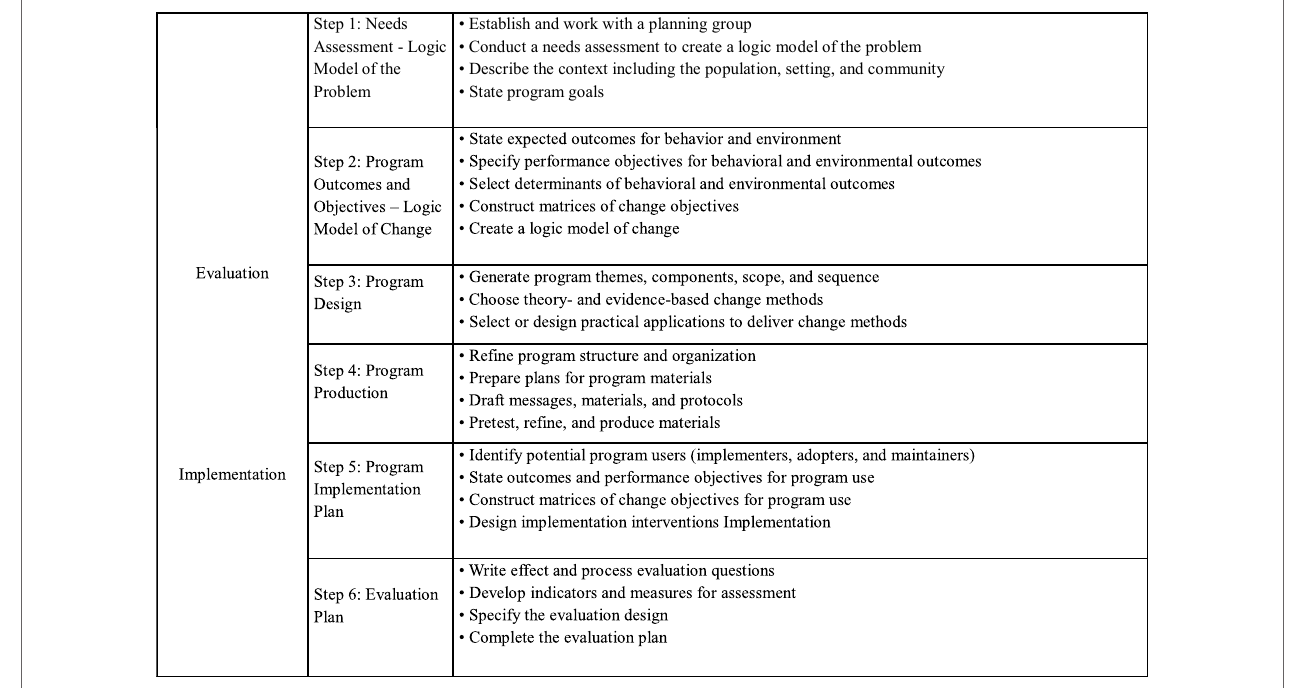
FIgUrE 1 | Intervention mapping steps and tasks [adapted from Bartholomew et al. (12), p. 13].